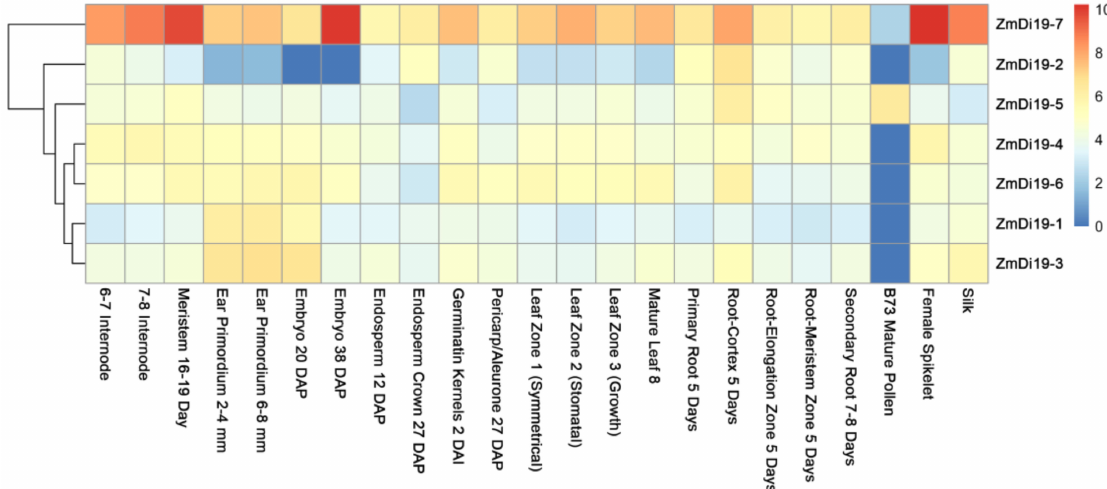
Figure 5. Expression profiles of ZmDi19 genes at different developmental stages. The color scale at the right of the figure indicates the FPKM normalized log2 values, and the heatmap was drawn using R package